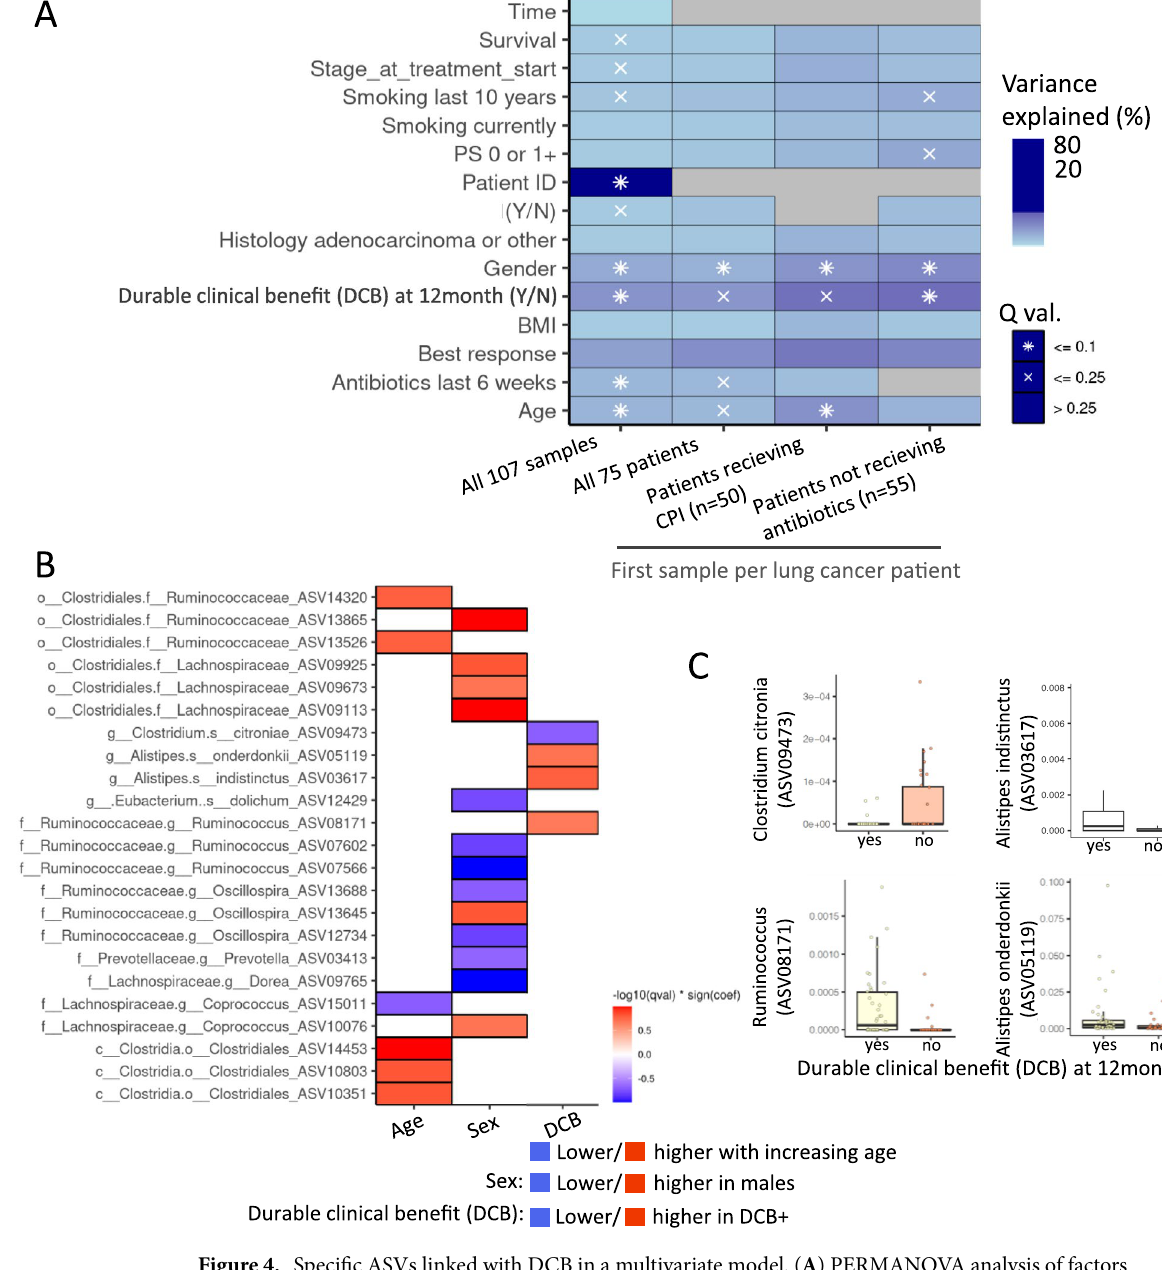
Figure 4. Specific ASVs linked with DCB in a multivariate model. ( A ) PERMANOVA analysis of factors explaining microbiome variance. Inter-individual sample variation explains most of the microbiome composition variation (left column, all 107 samples). When considering only one sample per patient in all the LC group (n = 75), those receiving immunotherapy, and those not receiving antibiotics, gender and DCB remain significant. Variance is estimated for each feature independently, while accounting for age, gender besides for when considering age or gender (see “Methods”) (Dataset S4). Included n for each subgroup is shown in brackets. ( B ) MaAsLin2 (multivariate association with linear models) was used to link ASVs to age, gender, and to DCB (controlling for subject, age, gender) in a multivariate model (Dataset S5). This resulted in 4 bacterial ASVs that showed significant relative differential abundance between DCB+ and DCB− patients. (Results after FDR correction < 0.25, p < 0.005). ( C ) Bar plot of those 4 ASVs taxa are We then calculated a Youden point that best discriminates between DCB+ and DCB− patients for those four bacterial ASVs taxa and accordingly stratified the 69 patients with available data to low or high abundance of each indicated ASV for Kaplan–Meier PFS comparison. Two of these four, Alistipes onderdonkii (ASV05119) Ruminococcus (ASV08171) (Fig. 5) showed significant results in Kaplan–Meier PFS, supporting the importance of these taxa. For Alistipes onderdonkii , Youden point of 0.00018 was calculated to discriminate between those with and without progression free survival (PFS) at 12 months. Patients with high Alistipes onderdonkii had